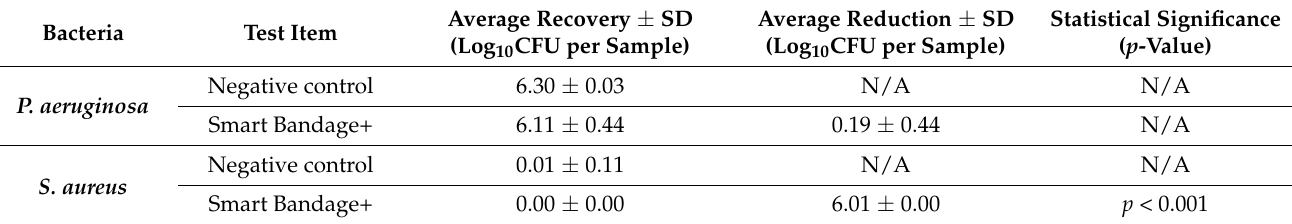
Table 1. Microbiological assessment of